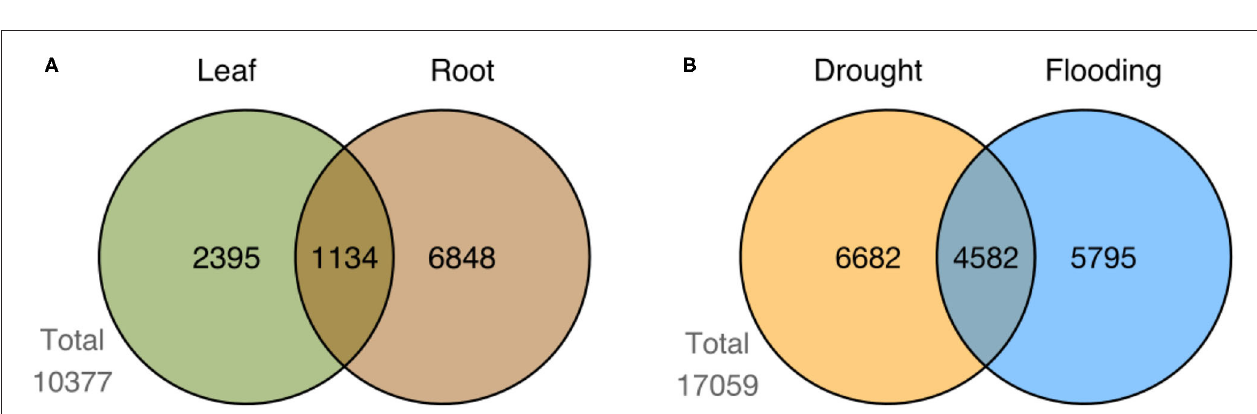
FIGURE 6 | Summary of DEGs by tissue and condition. Figure shows the number of shared and exclusive DEGs between leaf and root tissues in (A) flooding, and (B) the number of DEGs shared and exclusive to drought and flooding regardless the genotype or